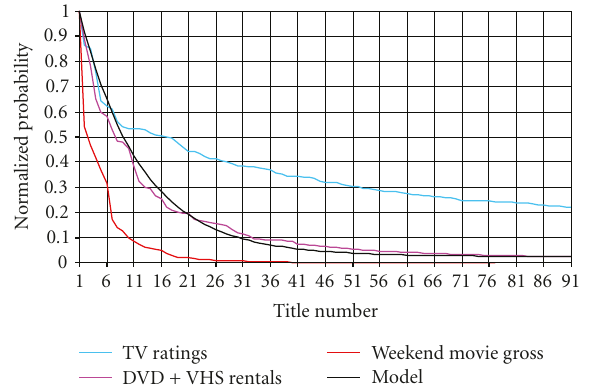
Figure 2: Video demand statistics and model. Statistics and probabilities are normalized so that the probability density of title number 1 = 1.